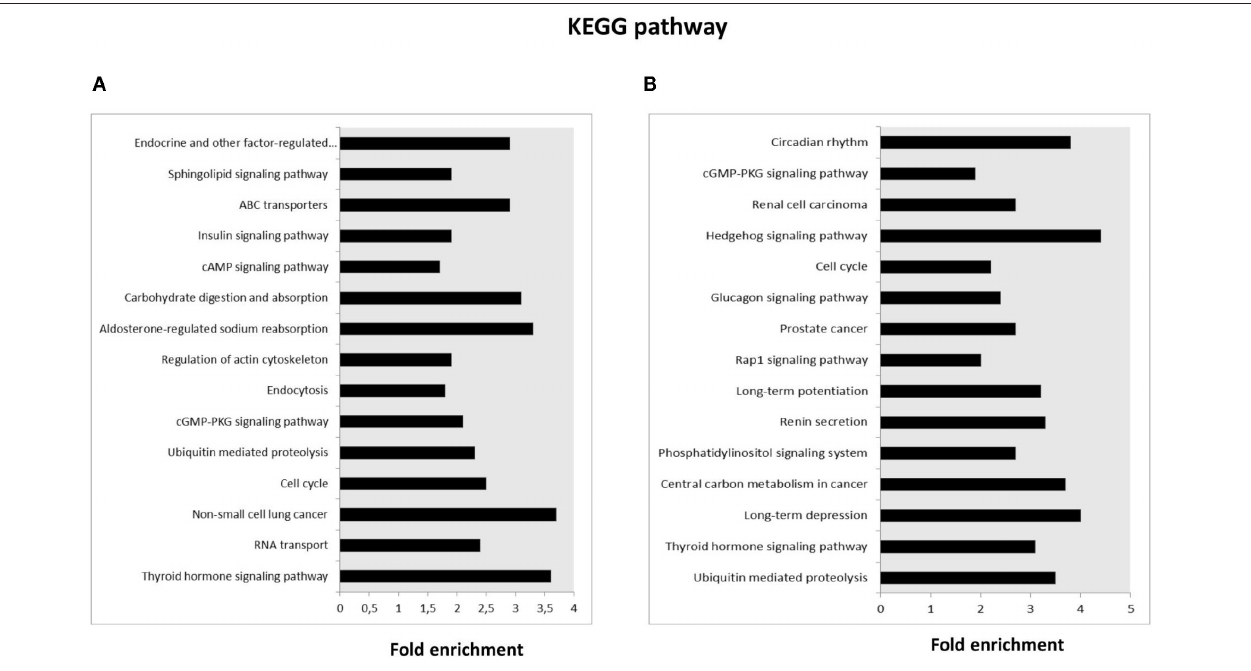
FIGURE 3 | Kyoto Encyclopedia of Genes and Genomes (KEGG) pathway annotation of host genes. (A) The Top 15 KEGG signaling pathway annotations of circRNAs up-regulated in fraction A asthenozoospermic derived SPZ. (B) The Top 15 KEGG signaling pathway annotations of circRNAs down-regulated in fraction A asthenozoospermic derived